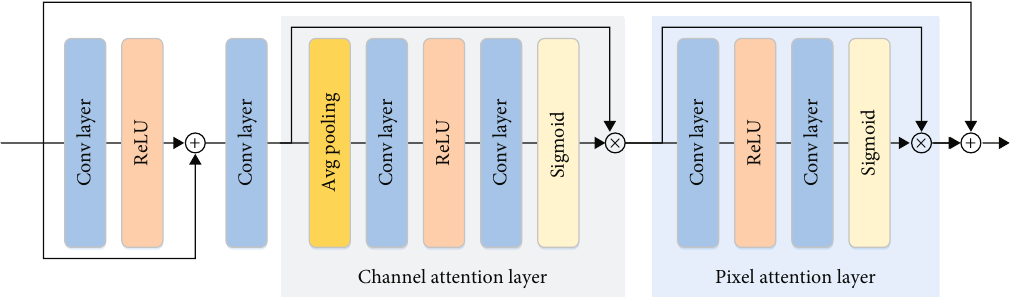
Figure 5: The pipeline of feature fusion module network module.